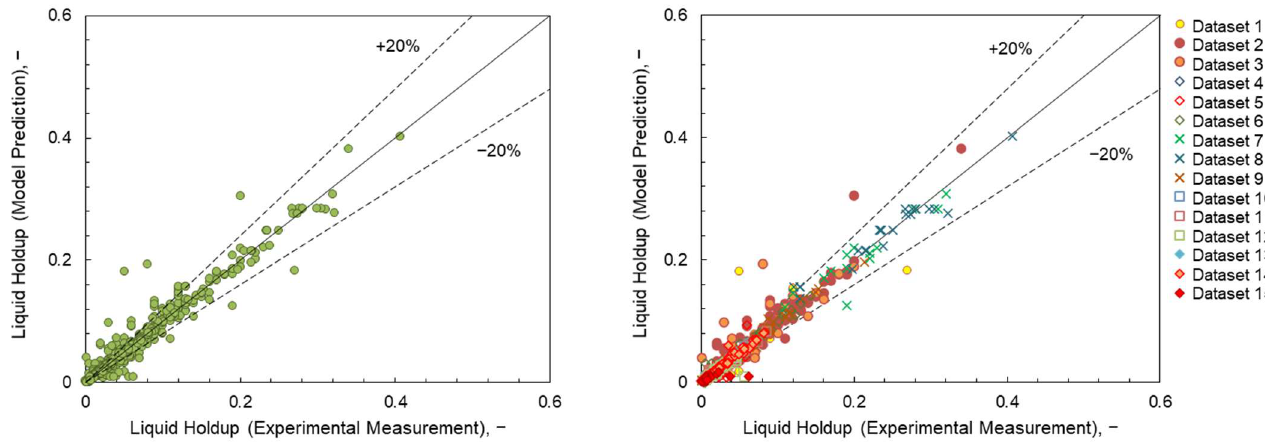
Figure 10. Comparison of experimental measurement and predictions for liquid holdup.